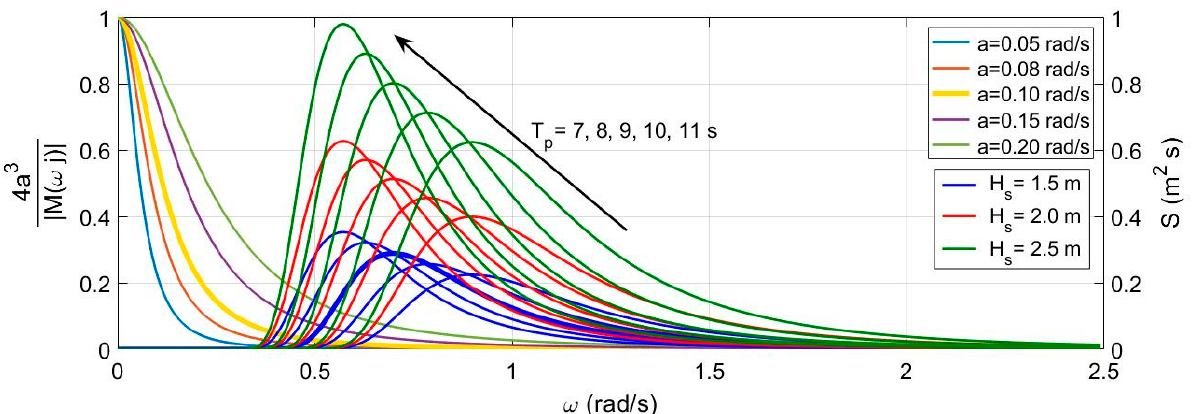
21 of 28 ( b ) Figure 13. Zoom of step responses for different gains of the controllers. ( a ) Zoom of the 𝜑 (cid:3051) re- sponses in the neighborhood of the instant 𝑡 (cid:2870)(cid:3087) = 400𝑠 . ( b ) Zoom of the 𝜃 (cid:3052) responses in the neighborhood of the instant 𝑡 (cid:2870)(cid:3101) = 550 𝑠 . 7.2. External Disturbances: Waves and Wind Various environmental models can be used to achieve realistic simulations of any kind of marine device. In this work, a classical wave spectrum 𝑊(𝜔, 𝜓) was used as a function of both the frequency 𝜔 and the direction 𝜓 , with a Pierson–Moskowitz (PM) spectrum [40]. Due to the closed loop dynamics expected for the device, owing to the presence of the superposed low frequency (LF) model and wave frequency (WF), only the LF effects will be considered as external disturbances. Figure 14 shows the PM spectrum for a significant wave height of 1.5 , 2 and 2.5 𝑚 for the peak periods of 7 , 8 , 9 , 10 and 11 𝑠 each (the values selected are the most fre- quent in the chosen location [29]), along with the Bode (a linear rather than a logarithmic plot for easy comparison) magnitude for the proposed closed loop desired dynamics with a different design parameter 𝑎 , whose values were 0.05 , 0.075 , 0.1 , 0.15 and 0.2 𝑟𝑎𝑑/𝑠 .